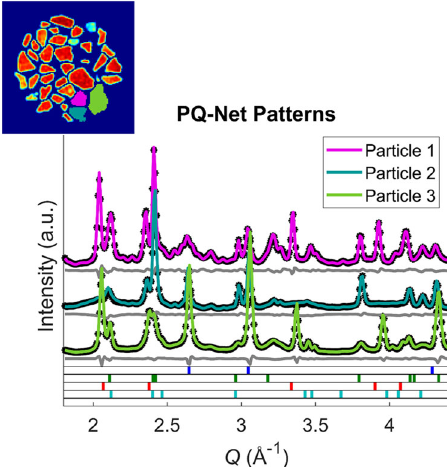
Fig. 4 Examples of fi tted simulated diffraction patterns from regions of interest. Comparison between the average diffraction patterns extracted from three particles of interest and the TOPAS generated patterns using the parameters predicted by the PQ-Net. The main re fl ections for NiO (blue ticks), PdO (green ticks), CeO 2 (red ticks) and ZrO 2 (cyan ticks) are also